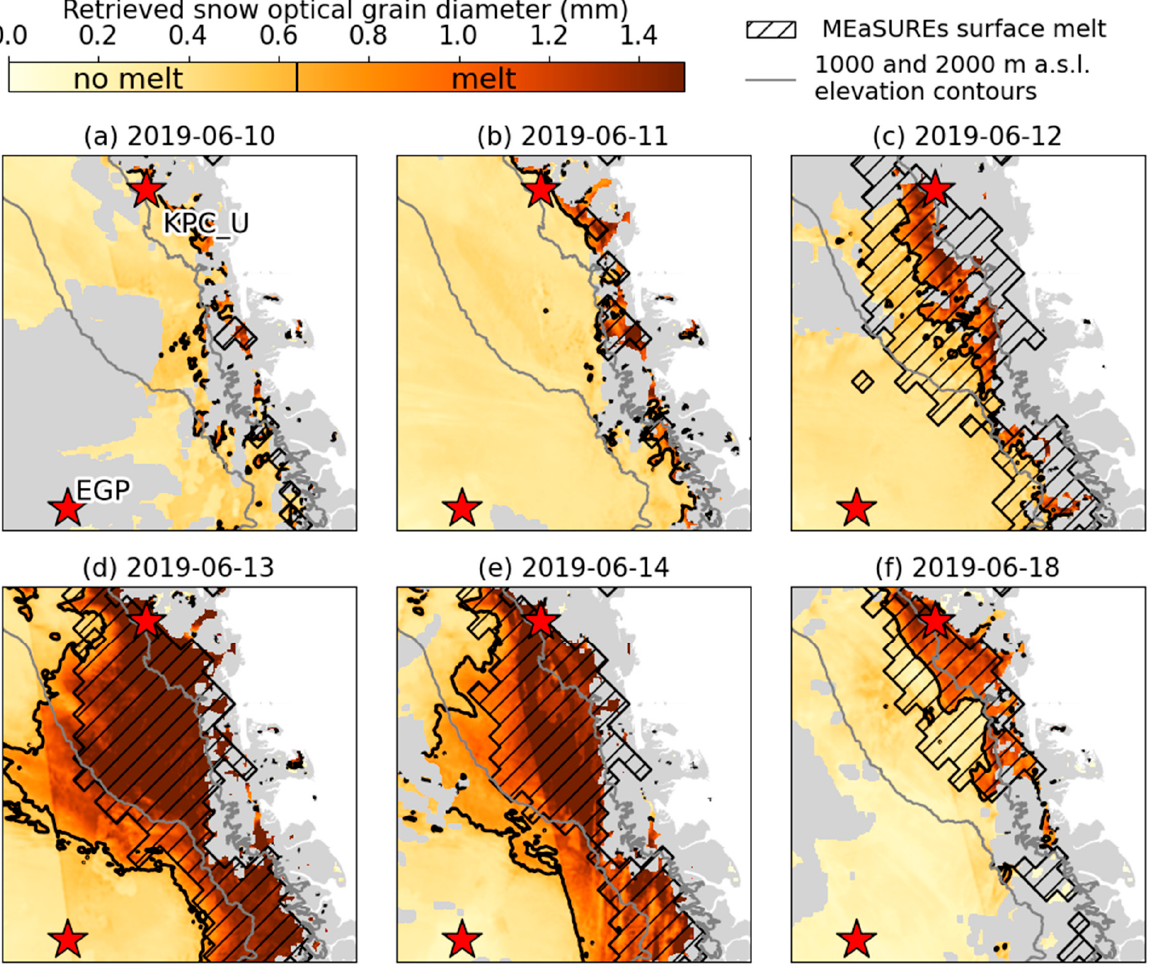
Figure 6. Optical snow grain diameter retrieval and associated surface melt flag (areas within the black line) and MEaSUREs melt flag for a 10–18 June 2019 heat wave in Northeast Greenland along with AWS locations (red stars) and elevation contours (gray lines, 1000 and 2000 m a.s.l.).